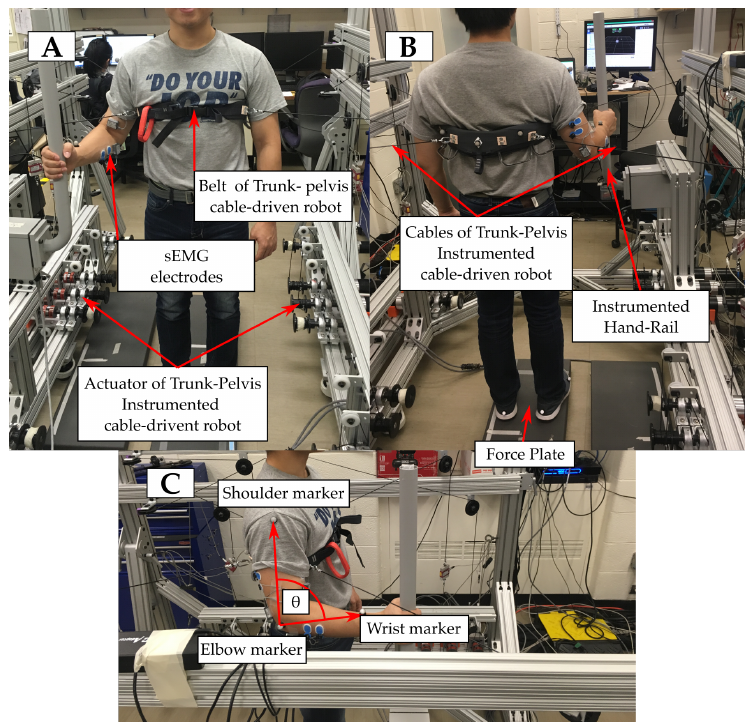
Figure 1. Overview of the experimental setup. ( A ) Frontal view of the setup with a subject in the HR condition, showing the grasping pose. Blue frame shows a detail of the same part in HR + E condition. ( B ) Rear view of the setup shows the placement of the markers that track the position of the end effector of the cable driven robot (belt). ( C ) Lateral view shows the position of the different markers to estimate the angle of the elbow. Indicators of the position of the different sEMG electrodes are distributed across the three